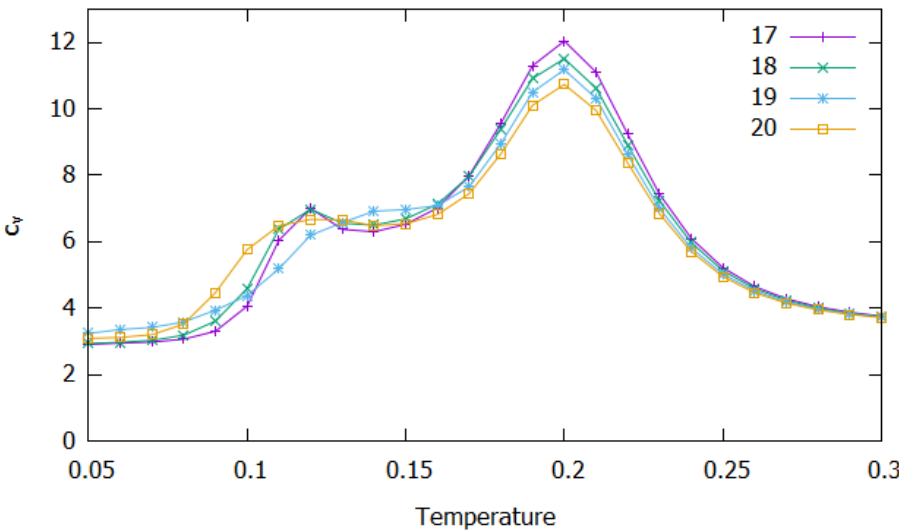
Figure 5. Reduced heat capacity as a function of temperature (in reduced units) for the cluster sizes of N = 17 (magenta), N = 18 (green), N = 19 (blue), and N = 20